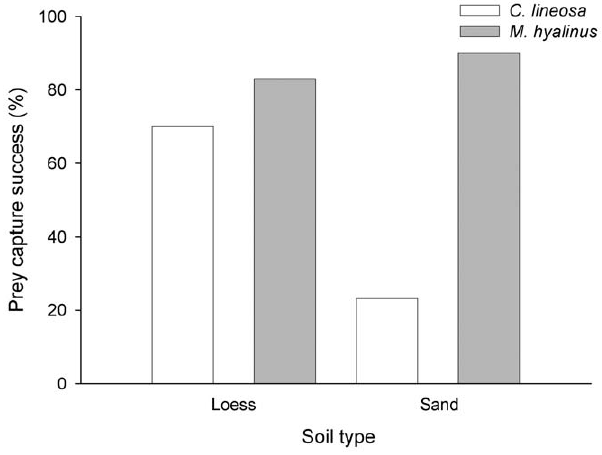
Figure 6. Prey capture success of antlions encountering different prey ant species. Prey capture success of both species did not vary among the different ant prey species. Prey capture success of M. hyalinus varied little between soils, but that of C. lineosa was markedly reduced when put in the sand. Notably, the prey capture success of the habitat generalist M. hyalinus was higher than that of the habitat specialist C. lineosa in both soil types.